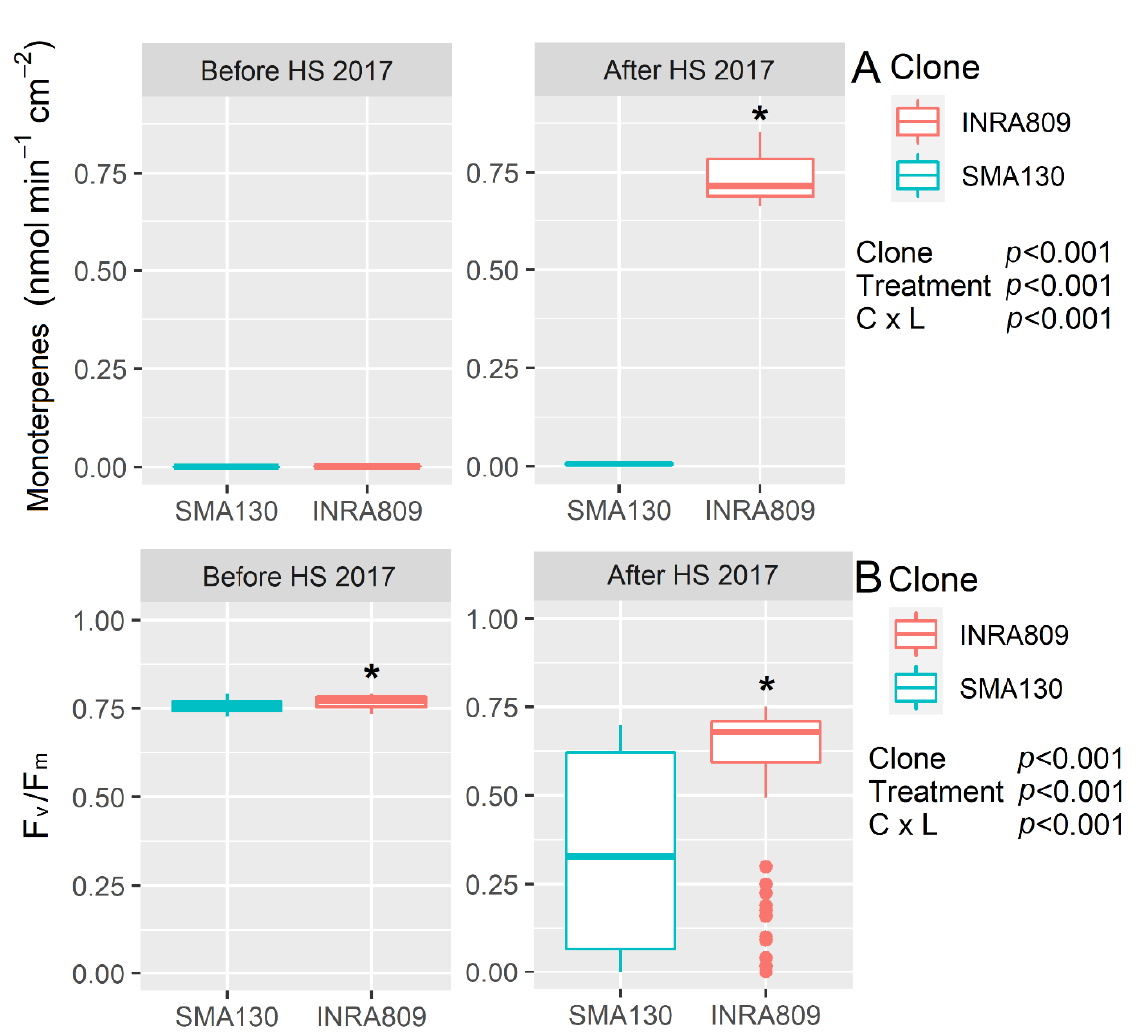
Figure 1. Monoterpenes emission ( A ) and maximum quantum yield of photosystem II in dark-adapted samples (F v /F m ) ( B ) analyzed in INRA809 and SMA130 before and after heat stress (HS) ( n = 20–30). Data were collected in 2017 and subjected to a two-way ANOVA. ANOVA output is shown in the figure and for each trait. Asterisks show significant differences between clones according to t -test.